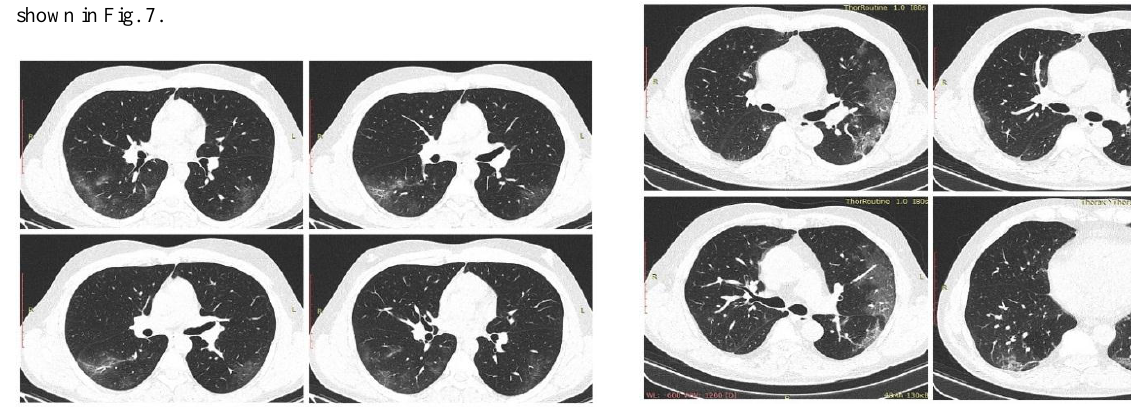
Figure 7 . CT image of patient 1, follow-up, resolution stage.